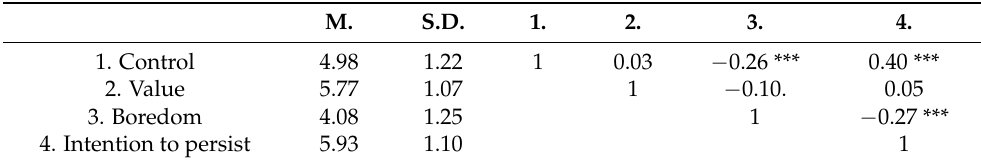
Table 1. Descriptive statistics and variable correlations.